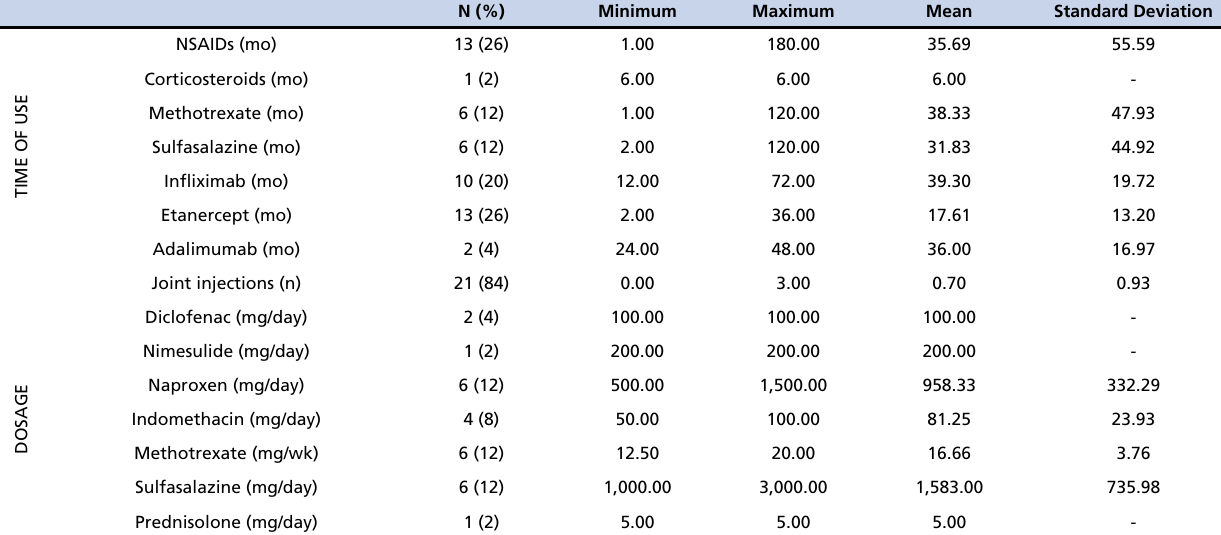
Table 2 - Drugs used in the Ankylosing Spondylitis